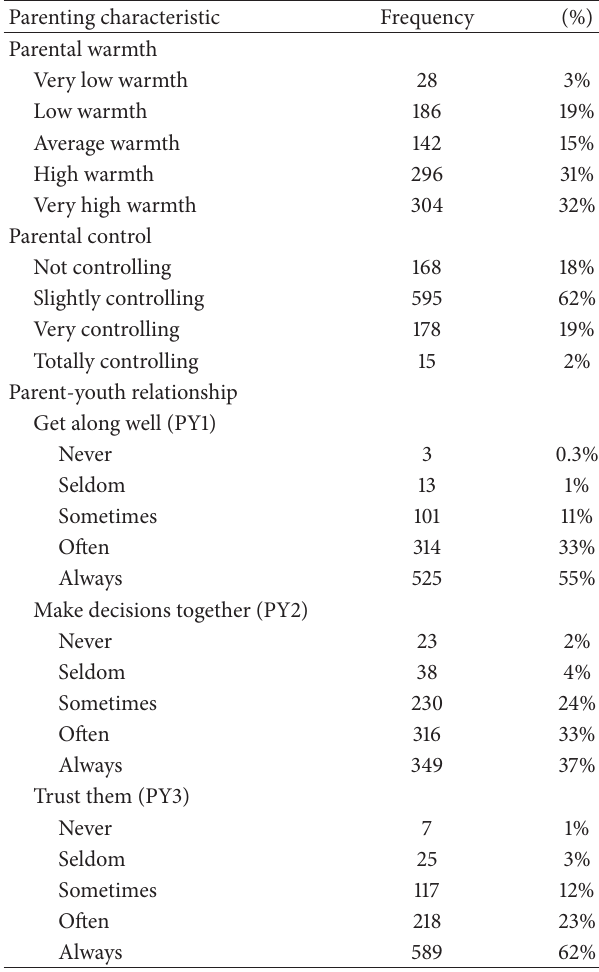
Table 2: Parenting characteristics of Mexican American families ( 𝑛 = 956